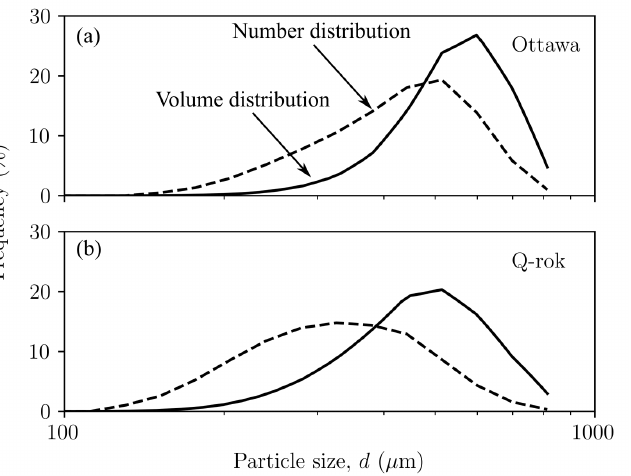
Figure 5. Volume and calculated number distribution of ( a ) Ottawa sand, and ( b ) Q-Rok from laser light scattering technique.